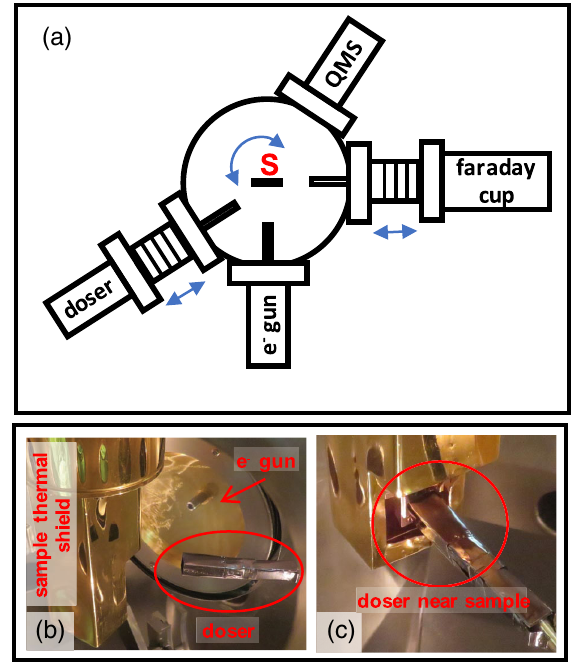
FIG. 1. (a) Schematic representation of the ultrahigh (UHV) vacuum experimental setup. Pictures (b) and (c) show the dosing configurations adopted in this study. Red labels indicate the different components. (b) In the retracted position, the doser is far from the sample (S) and secondary electron yield (SEY) measurements can be performed during gas delivering. (c) Putting the doser very close to the sample allows to reduce the back- ground signal in TPD